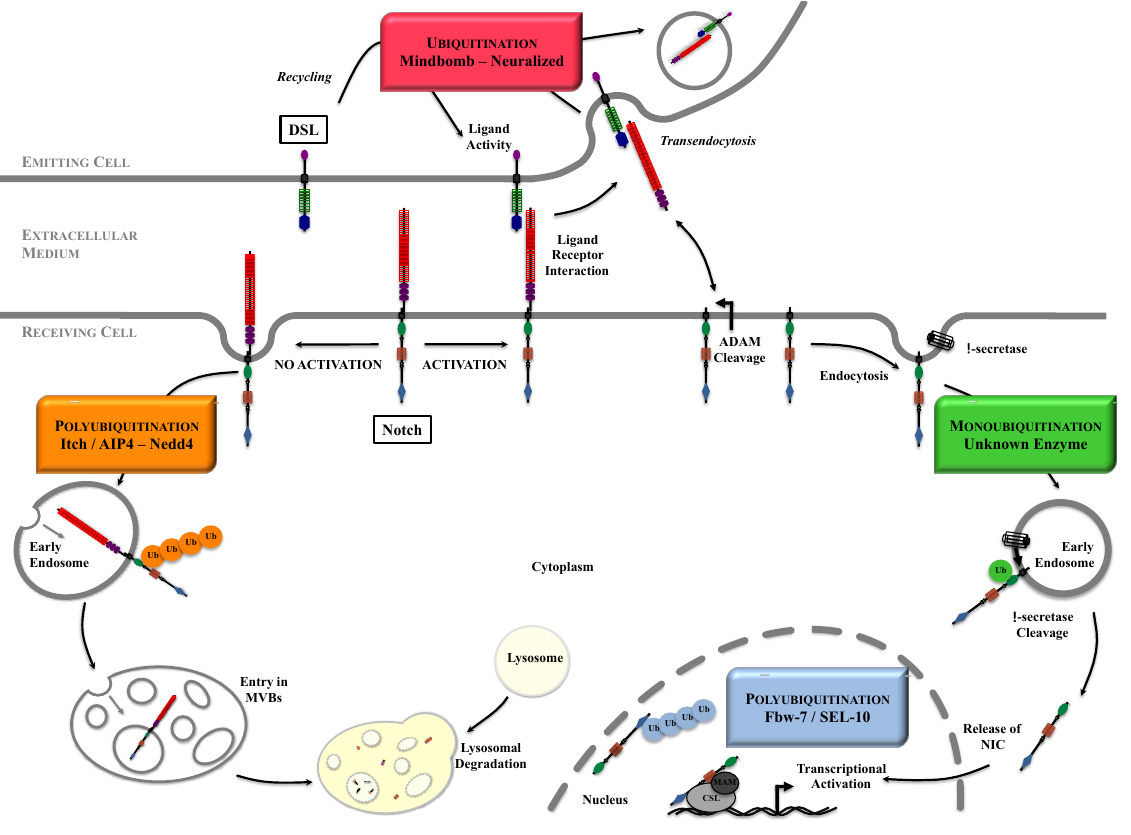
Figure 2. An overview of Notch signaling. The steps requiring ubiquitination are highlighted. In the absence of activation, Notch is internalized and degraded in the lysosomes. DSL ligands activity depends on trafficking and ubiquitination. Upon ligand binding, Notch extracellular domain is transendocytosed into the ligand-expressing cell, and the remaining receptor undergoes proteolytic cleavages as well as ubiquitination and deubiquitination to become a transcription